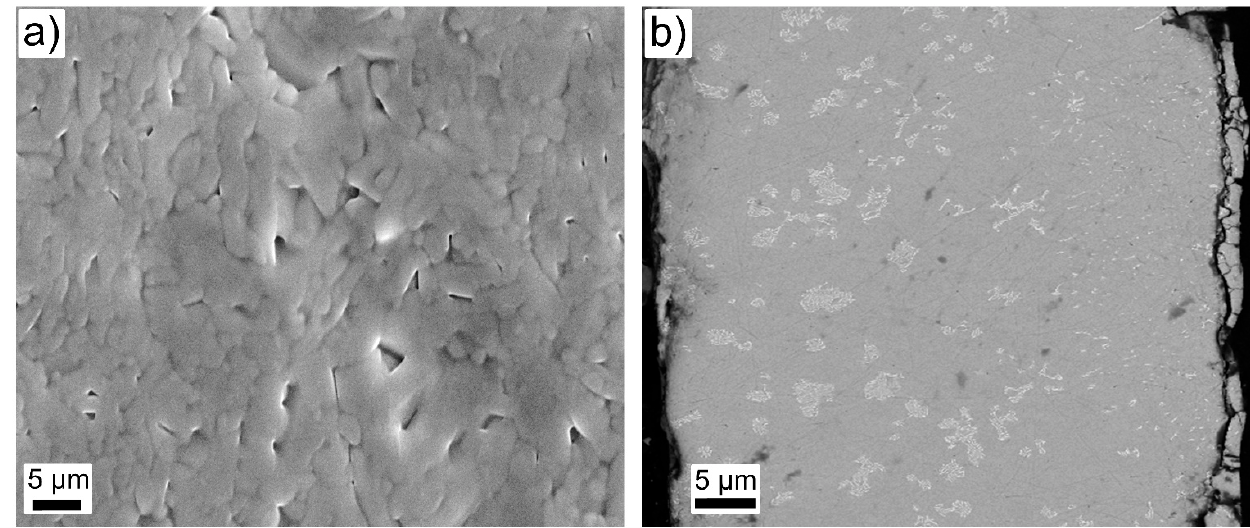
Figure 1. ( a ) Scanning electron microscopy-Secondary electron (SEM-SE) image of surface view of as-prepared ribbon and ( b ) SEM-back-scattered electron (BSE) image of mirror-polished cross-section of as-prepared ribbon.